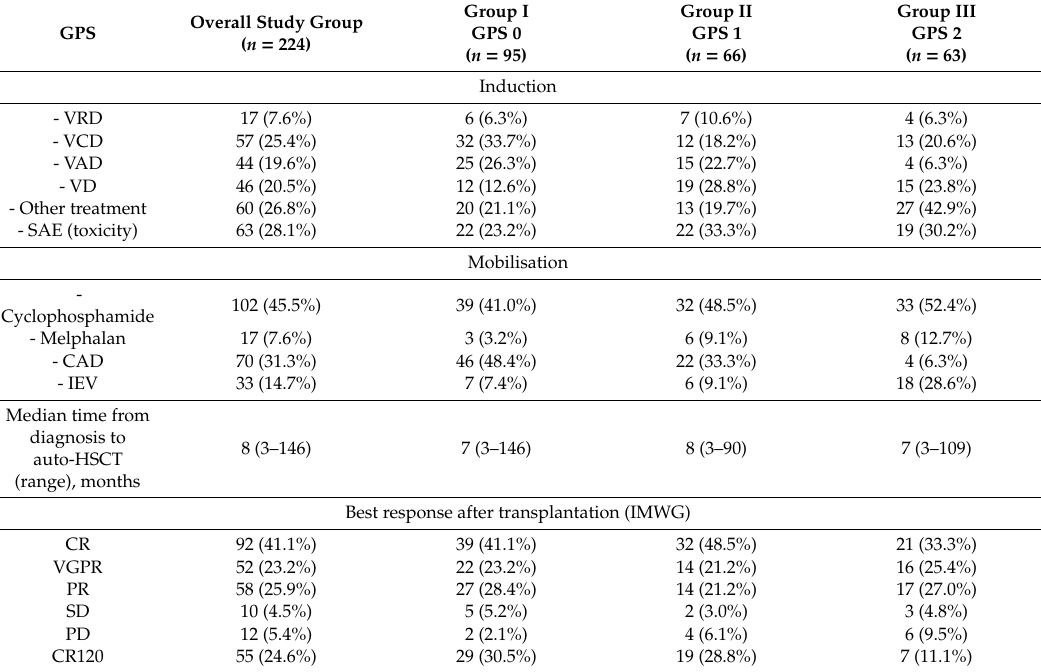
Table 4. Therapeutic characteristics of all patients included in the